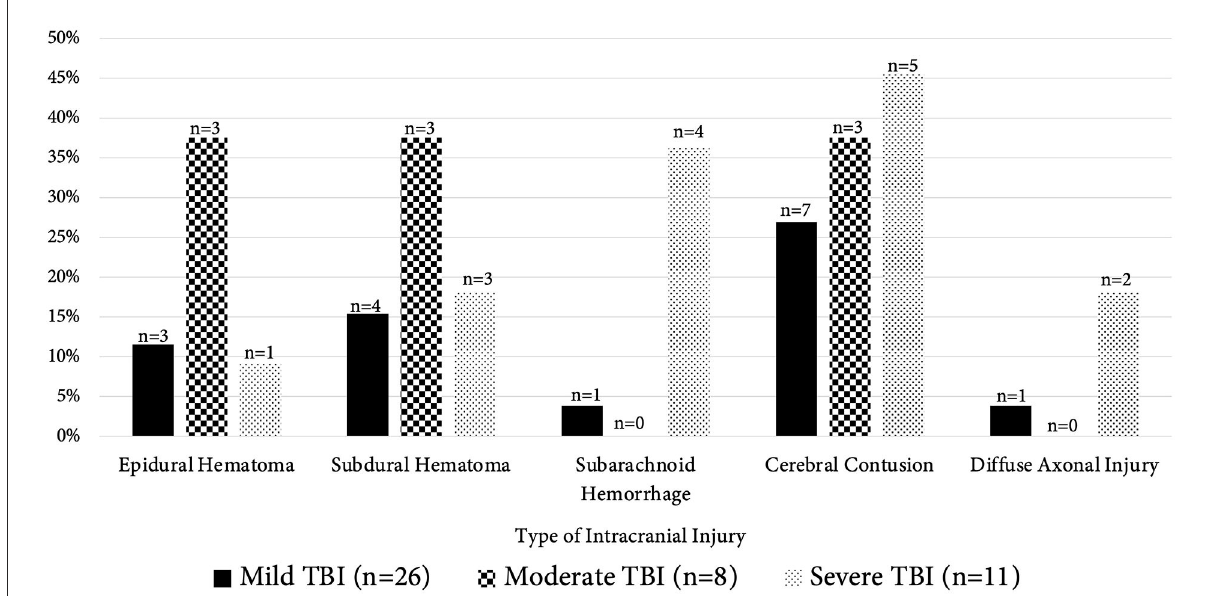
FIGURE2 Abnormal computed tomography findings by TBI severity. This figure demonstrates the distribution of abnormal head computed tomography findings in patients between TBI severity groups (mild TBI [GCS score 14–15, black columns], moderate TBI [GCS 9–13, checkerboard columns], severe TBI [GCS 3–8, dotted columns]). The x-axis contains the various abnormal intracranial findings noted on imaging; the “ n ” at the top of the bar represents total number of patients that had that particular radiographic finding while total group n of patients with imaging in each TBI severity is given in the lower legend (mild TBI, n = 26; moderate TBI, n = 8; severe TBI, n = 11). The y-axis represents the percentage of patients that had those radiographic findings. TBI, traumatic brain